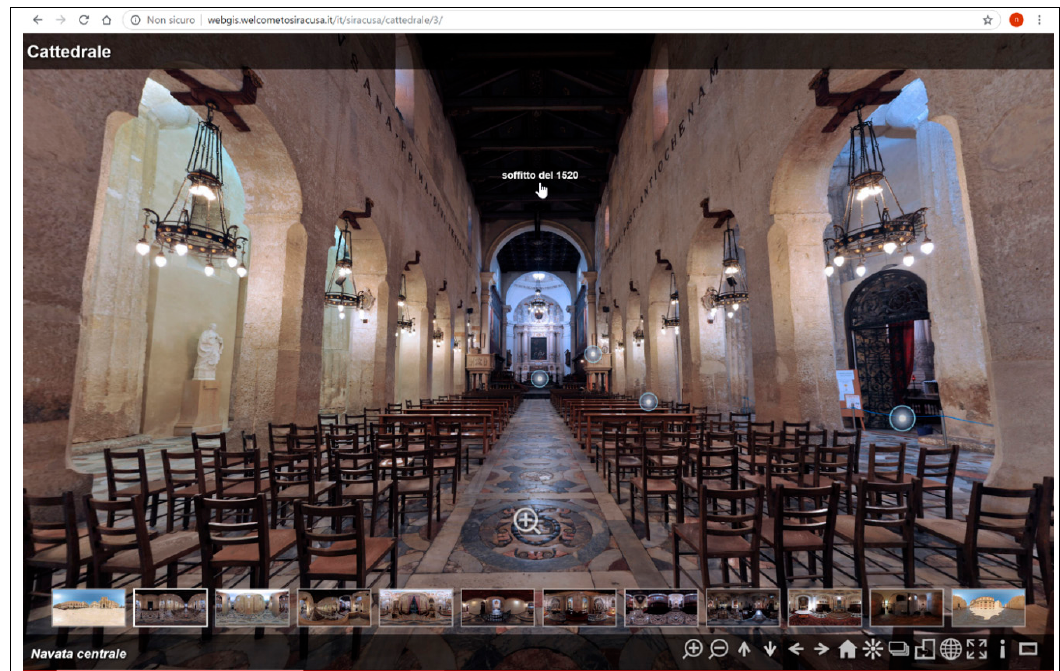
Figure A7: “Duomo di Siracusa”. Command bar, scene previews, hotspots, link among scenes, floor plan, map [28].